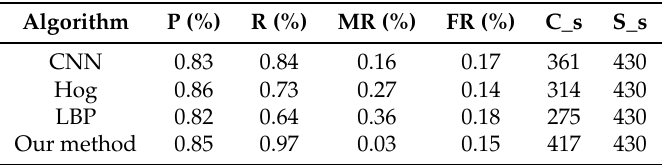
Table 1. Comparison of accuracy and recall of ships by different methods.